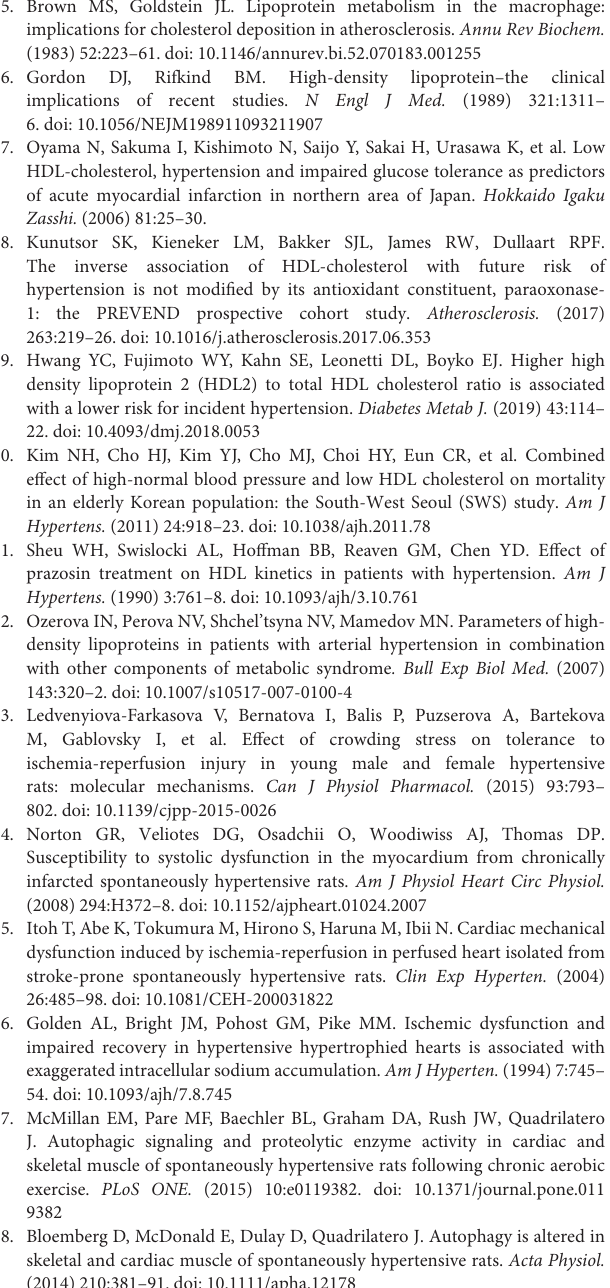
Supplementary Figure 1 | Heart to tibia length ratios. Herat weights of WKY and SHR rats implanted with vehicle or HDL containing pumps were expressed relative to tibia lengths. Data are mean ± SEM, n = 7–10 rats per